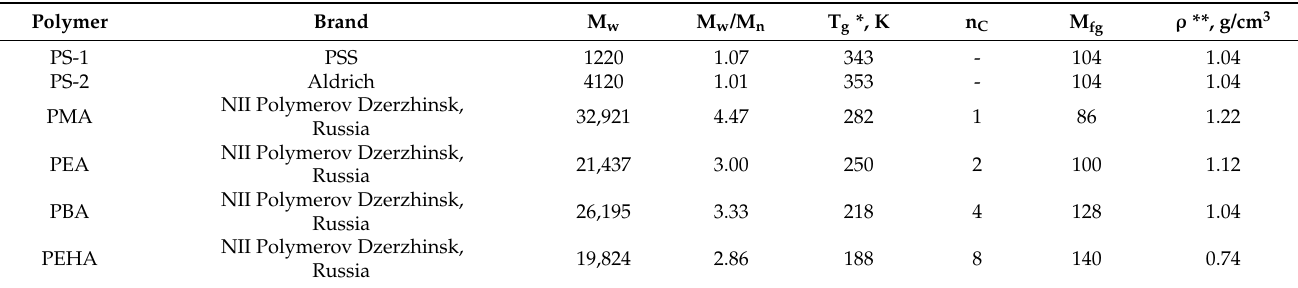
Table 1. The characteristics of the studied